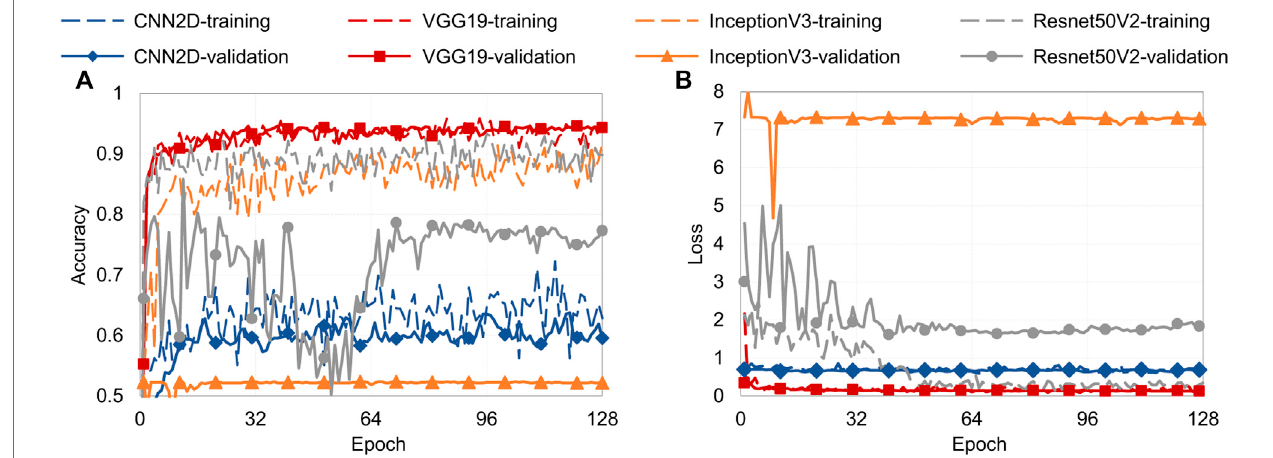
FIGURE 7 | Detailed training process for deep neural networks: (A) training and validation accuracies of CNN2D, VGG19, ResNet50V2, and InceptionV3 network models, and (B) training and validation losses of CNN2D, VGG19, ResNet50V2, and InceptionV3 network models.